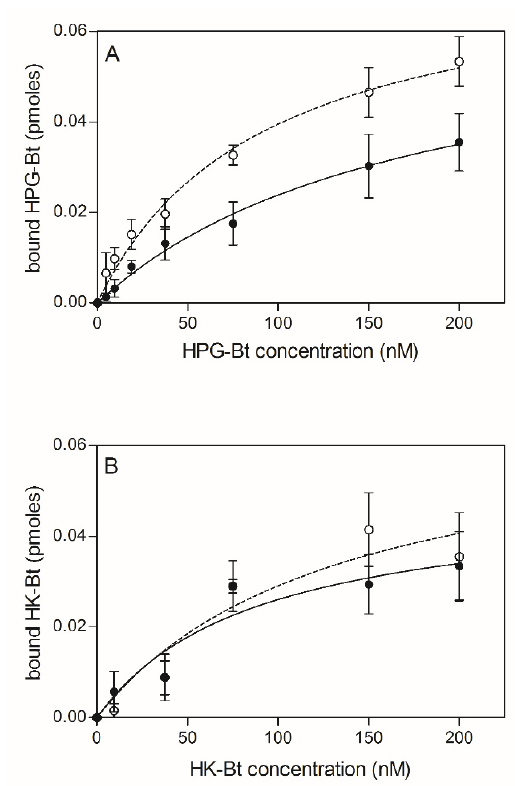
Figure 4. Binding of biotinylated human plasma proteins HPG-Bt ( A ) and HK-Bt ( B ) to C. albicans hyphae treated with P. gingivalis PPAD. The solid line and closed symbols refer to C. albicans cells incubated with 0.1 µ M PPAD for 2 h. The dashed line and open symbols refer to unmodified fungal cells. Data points represent the mean values ± SEM.